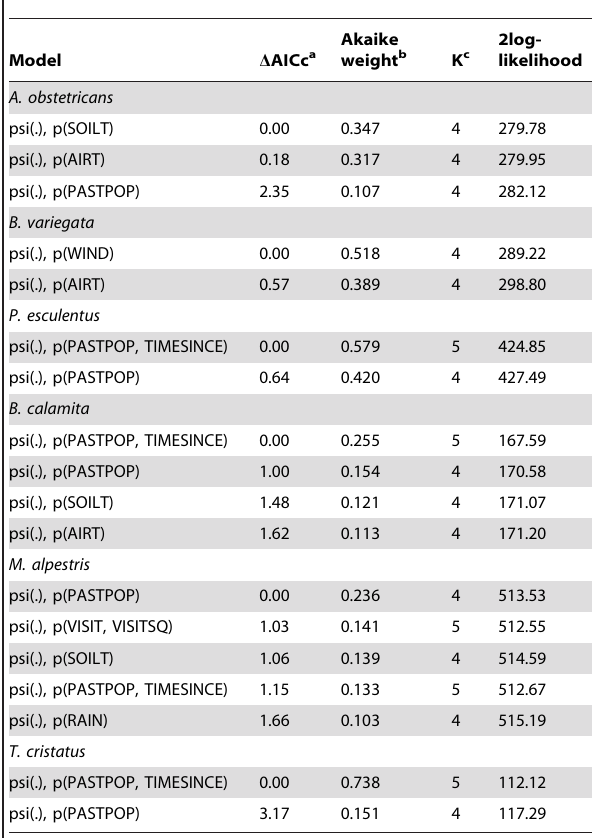
Table 1. Summary of model selection results for each